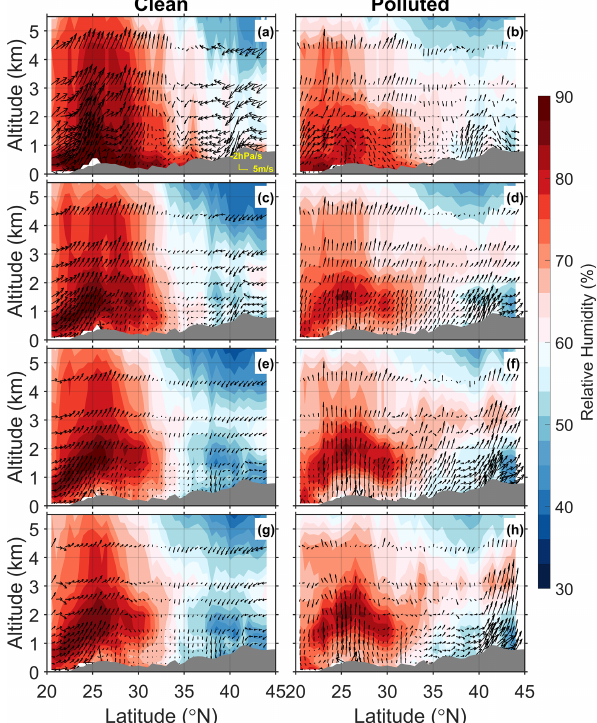
Figure 12. Latitude–altitude cross sections of mean relative hu- midity (color shaded) and mean meridional–vertical wind (vectors) over the continent, averaged along 105 to 125 ◦ E for clean (left panels) and polluted (right panels) conditions at (a, b) 08:00LT, (c, d) 11:00LT, (e, f) 14:00LT, and (g, h) 17:00LT during May– September from 2016 to 2017. Vectors are constructed from the easterly wind ( u ) and vertical velocity ( ω ), scaled with − 100. Gray shaded parts are the meridional mean terrain heights within